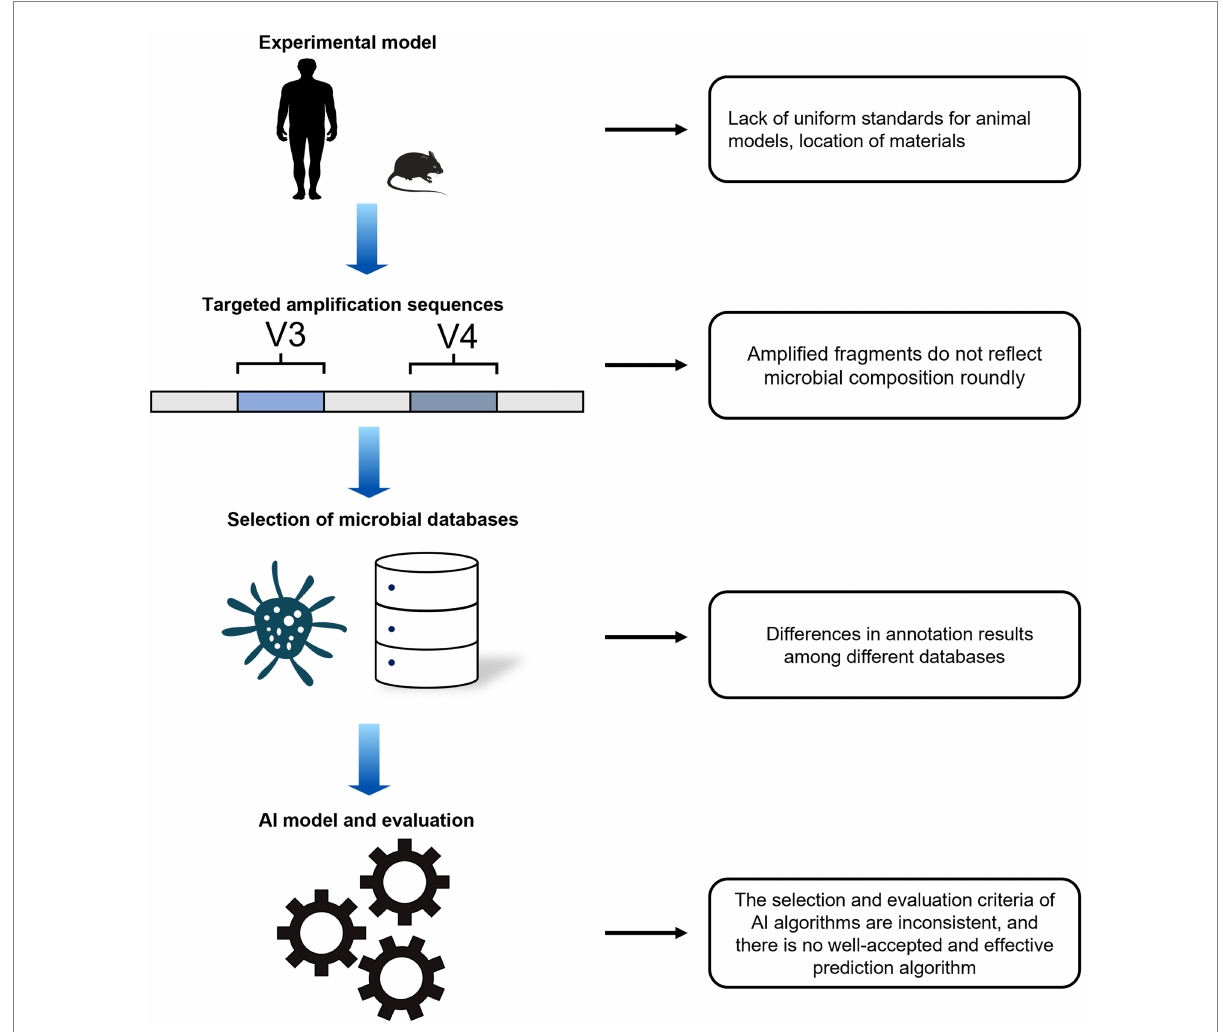
FIGURE 1 Problems for AI prediction of